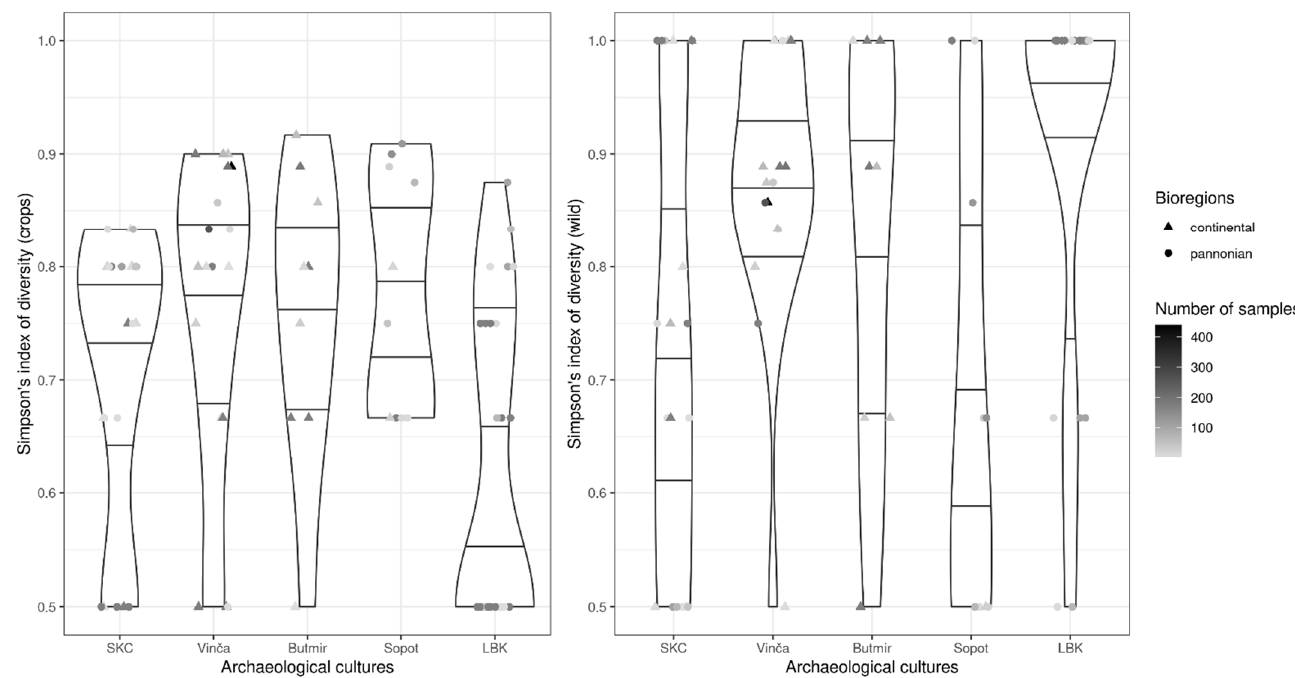
Figure 5. Simpson’s indices of diversity (1-D) for crop assemblages and wild species by site within cultural groups.